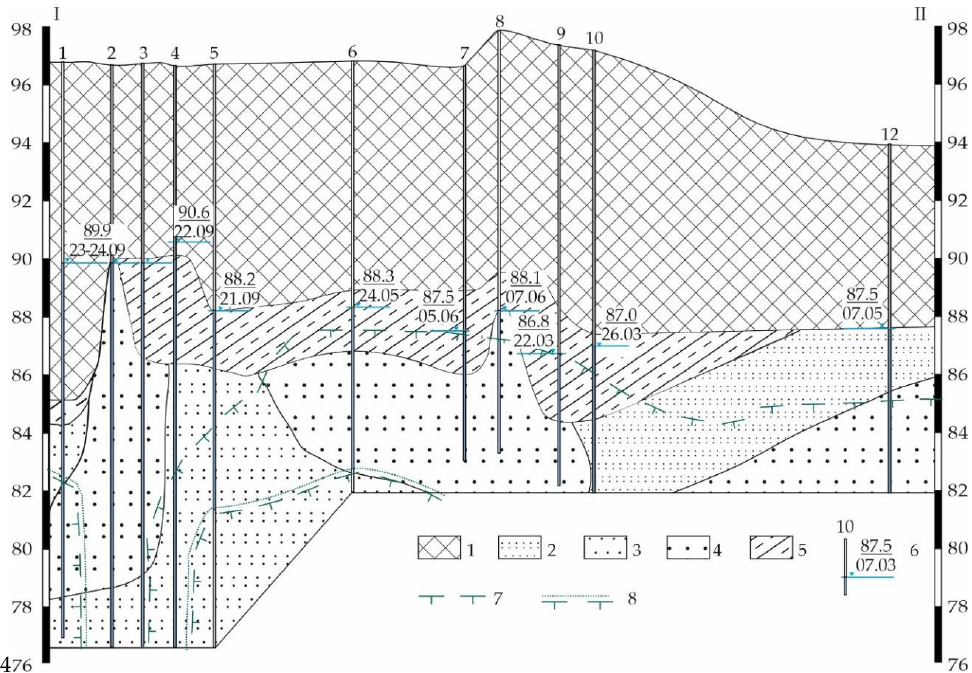
Figure 4. Cross-section along line I–II showing groundwater and permafrost levels (compiled by M.V. Danzanova from boring logs by YakutTISIZ Co. (1990) and Burstroy Ltd. (2016). 1–5—Soil lithology: 1—made ground (medium sand), 2–5—alluvial deposits: 2—silty sand; 3—fine sand; 4—medium sand; 5—sandy and clayey silts; 6—borehole with borehole no. (top), suprapermafrost groundwater level in 2016, m a.s.l. (numerator) and measurement date (denominator); 7—permafrost table in 1990; 8—permafrost table in 2016.